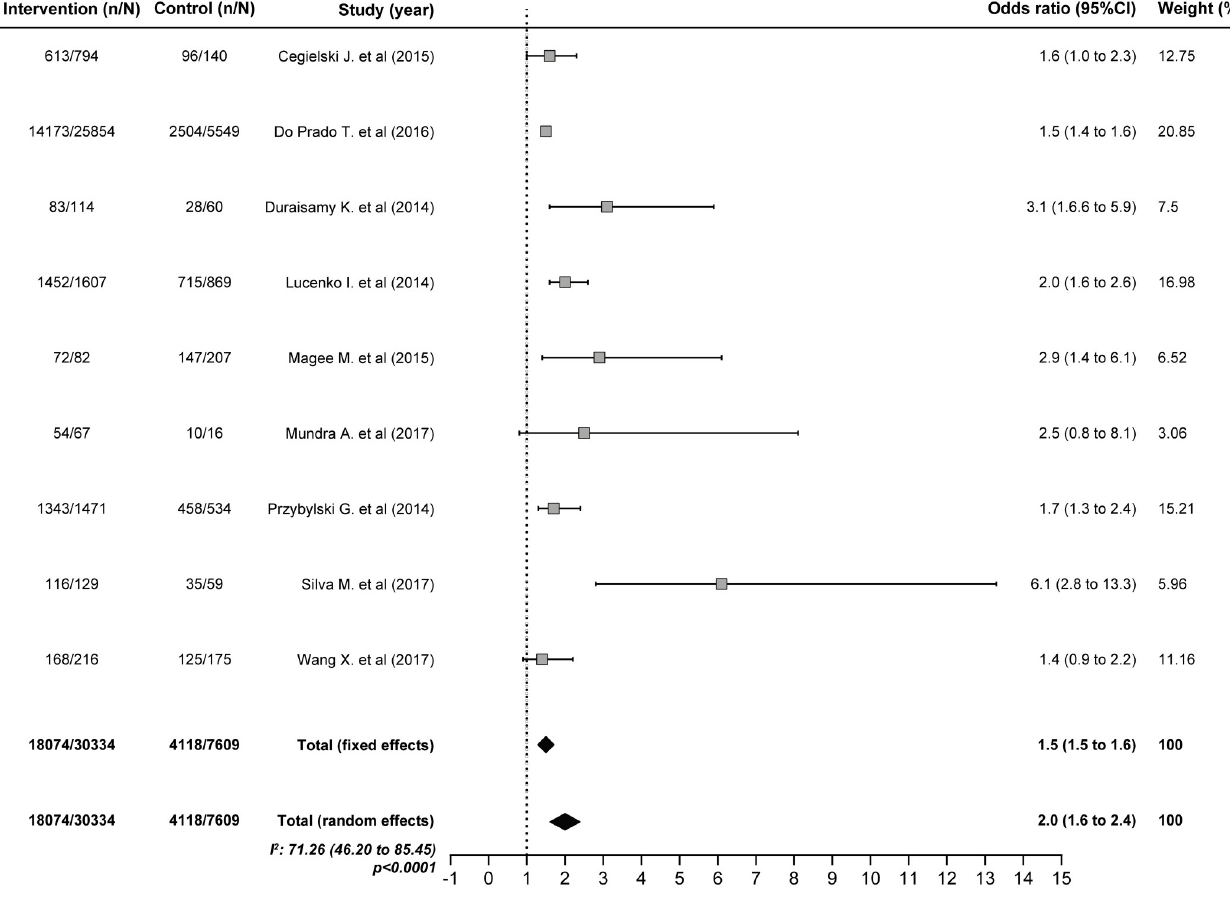
Fig 5. Pooled estimate to Non-alcoholic as a factors predictive of favorable outcomes of tuberculosis treatment.